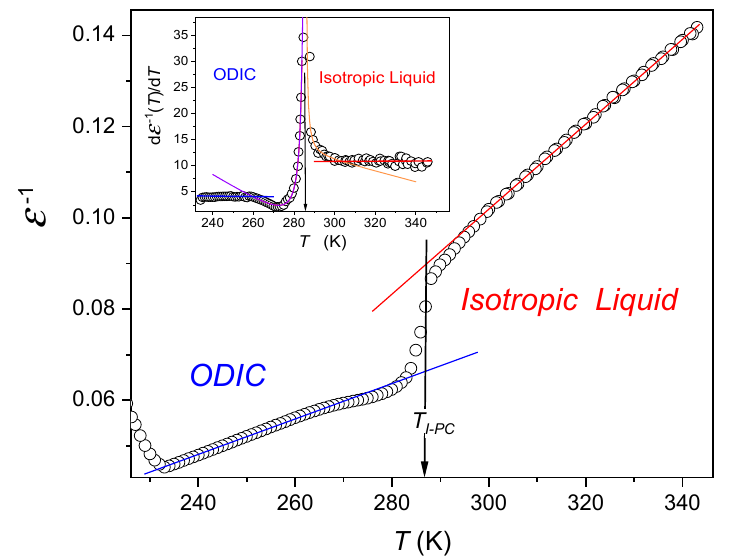
Figure 4. The evolution of the reciprocal of dielectric constant in cyclooctanol. The plot is based on experimental shown in Figure 4. In the isotropic liquid and in the notable part of the ODIC phase, the ε − 1 temperature dependence exhibits linear temperature dependence, suggesting the validity of Equation (6a) with extrapolated singular temperatures T + = 195 K (blue line) and T + = 115 K (red line). The derivative-based and distortions sensitive analysis in the upper inset confirms the mentioned behavior, also revealing a distortion in the very immediate vicinity of T m . It can be portrayed by Equation (6b), what is shown by solid curves.